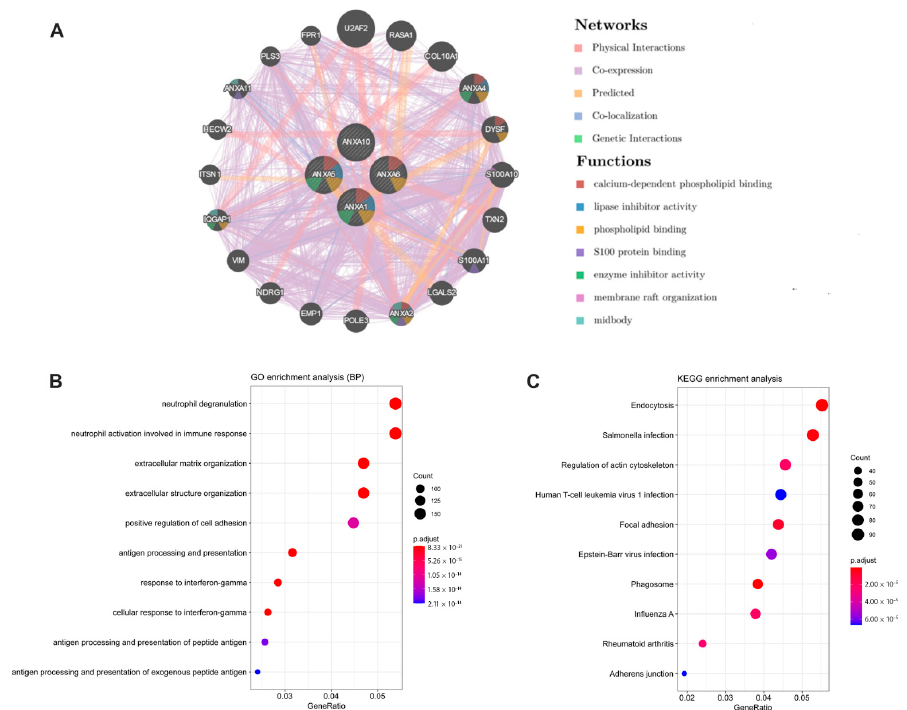
Figure 7. Results of gene-gene interaction network (GeneMANIA) and functional enrichment analyses between the high/low risk groups. ( A ) Gene-gene interaction network analysis of ARPS members (GeneMANIA); ( B ) GO enrichment analysis (Biological Process); ( C ) KEGG pathway analysis.